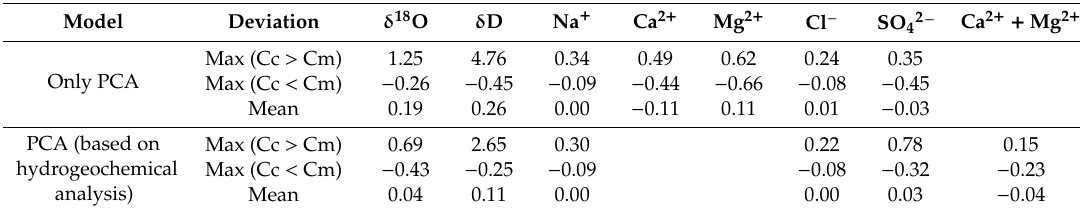
Table 3. Deviations of all ions and isotopes in two mixing